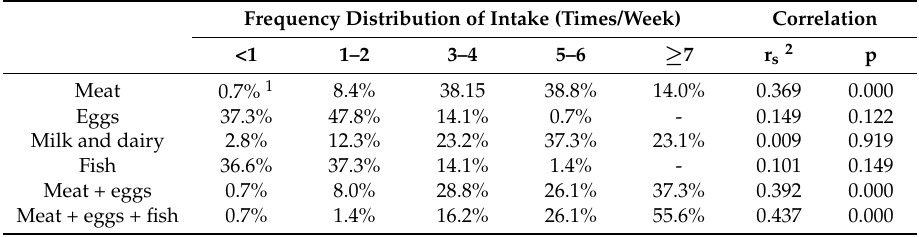
Table 2. Frequency distribution of food intake in study population and correlation of food intake with plasma